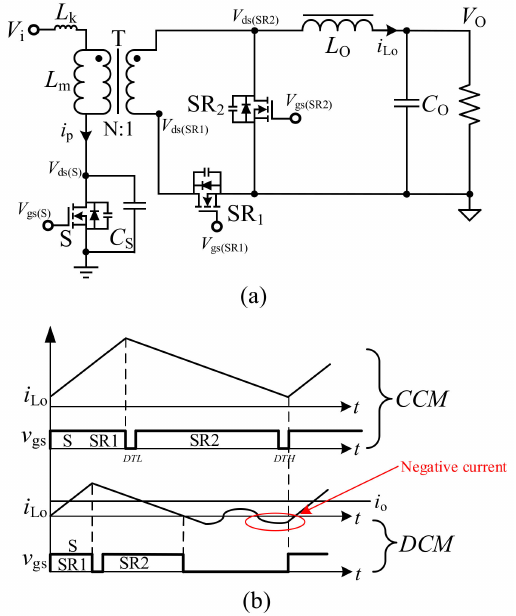
Figure 1. ( a ) Forward circuit with synchronous rectifiers. and ( b ) inductor current and gate-drive signal in continuous conduction mode and discontinuous conduction